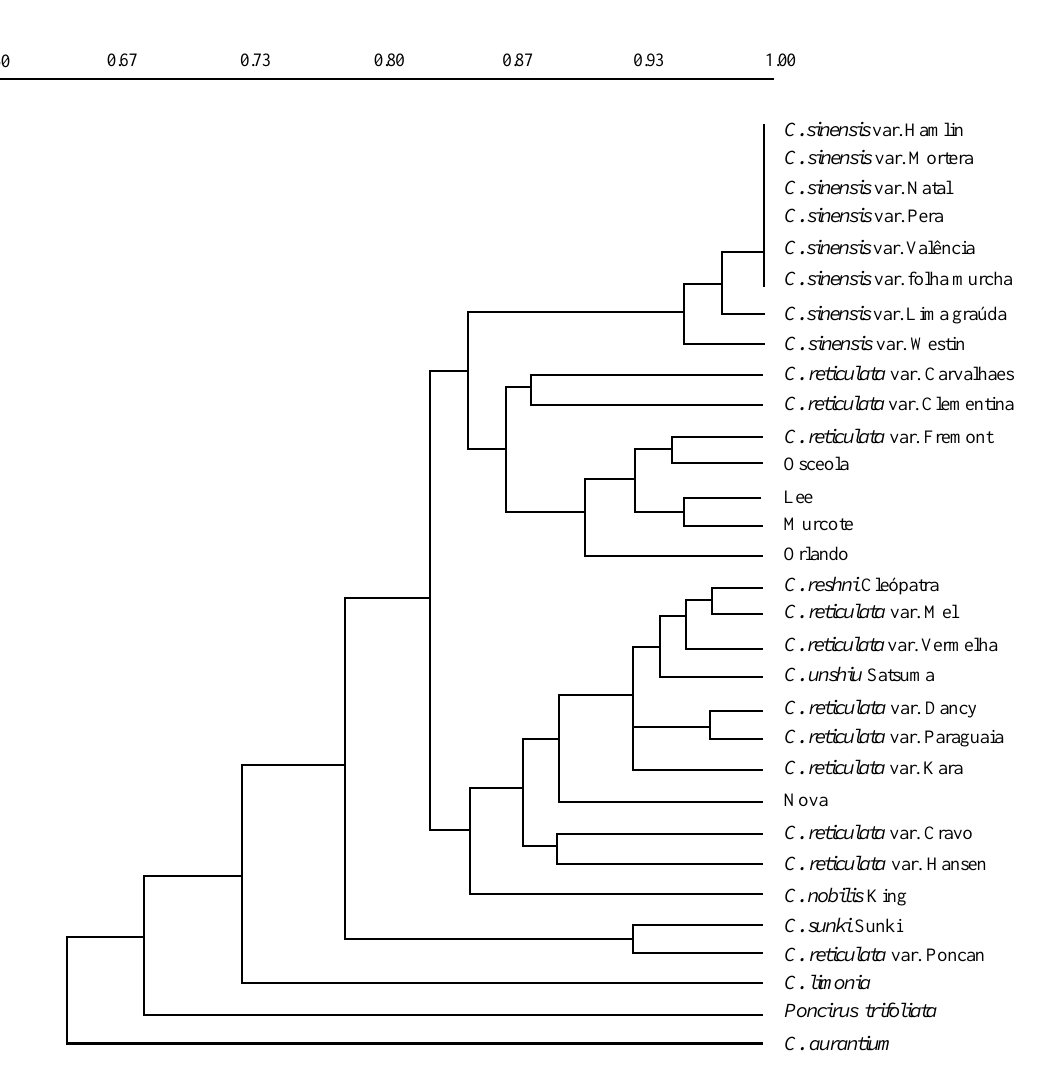
Figure 1 - UPGMA cluster (Nei, 1978, in Swofford and Selander, 1989) identity genetic coefficient matrix of isoenzy- matic polymorphism for different species of Citrus , their hybrids and Poncirus trifoliata (L.)